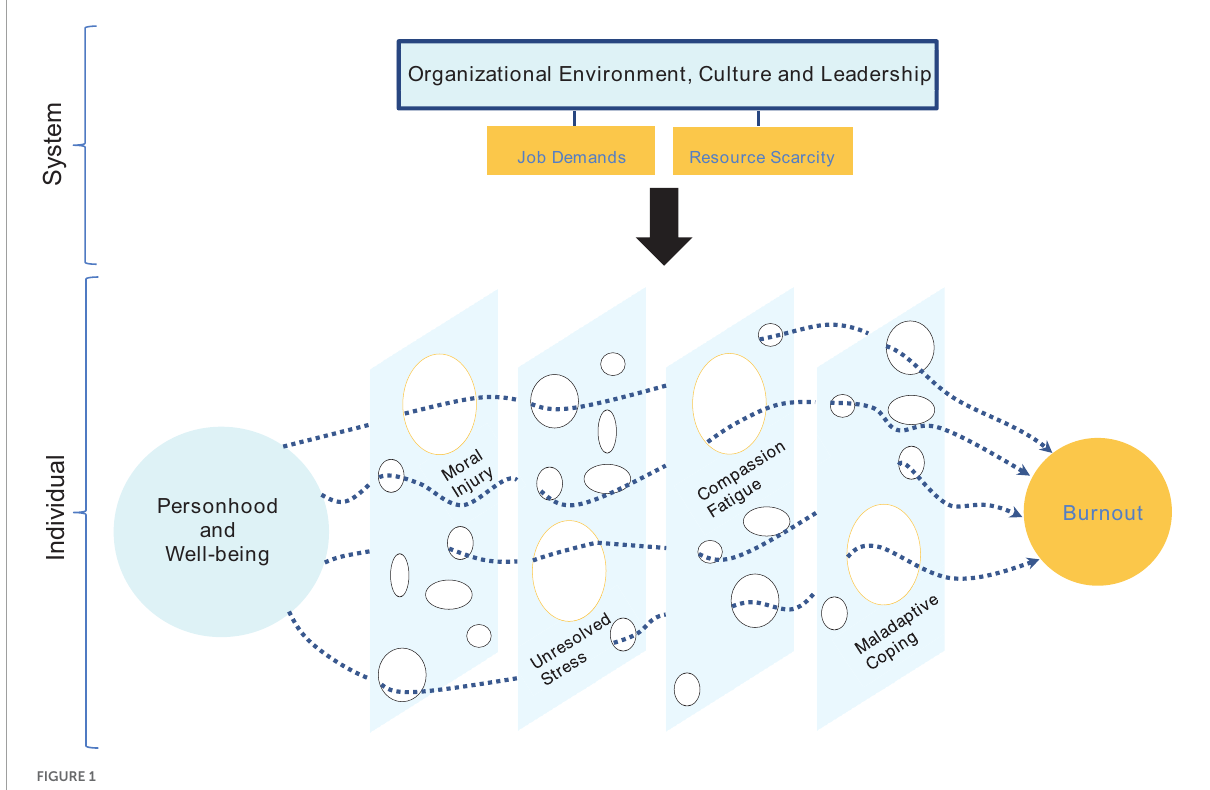
FIGURE1 The system individual burnout spectrum model (authors’